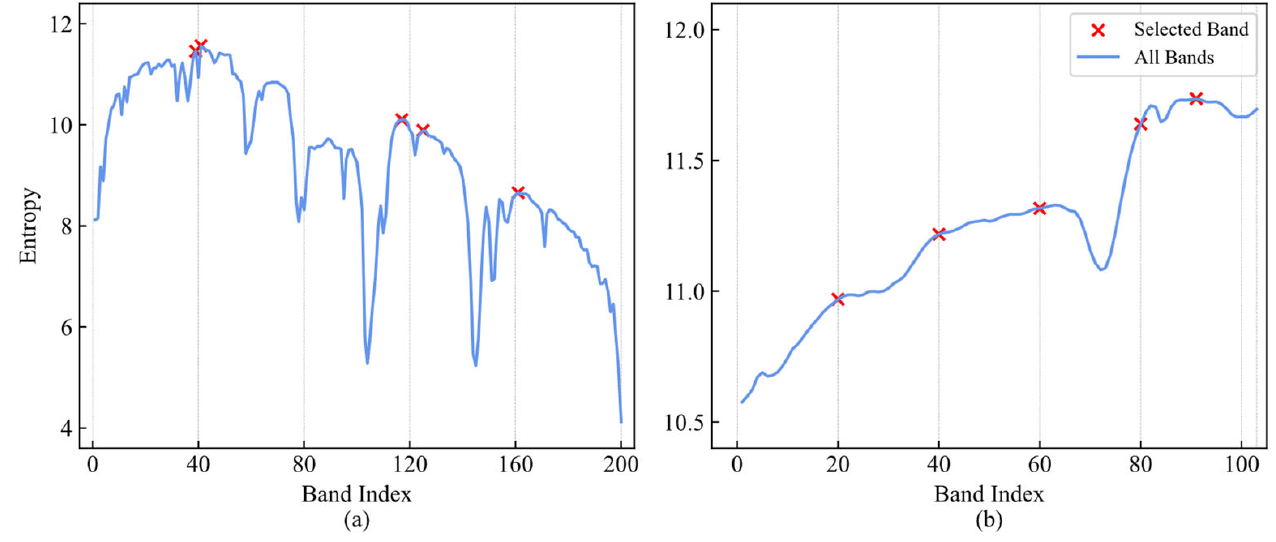
Figure 3. Information entropy for each band on two datasets is divided into five groups. ( a ) Indian Pines; ( b ) Pavia University.